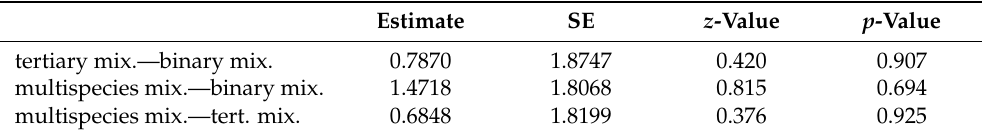
Table A4. Effect of management (grazed, ungrazed) on the ICE diversity index of wild bees. binary mix. ungr.—binary mix.